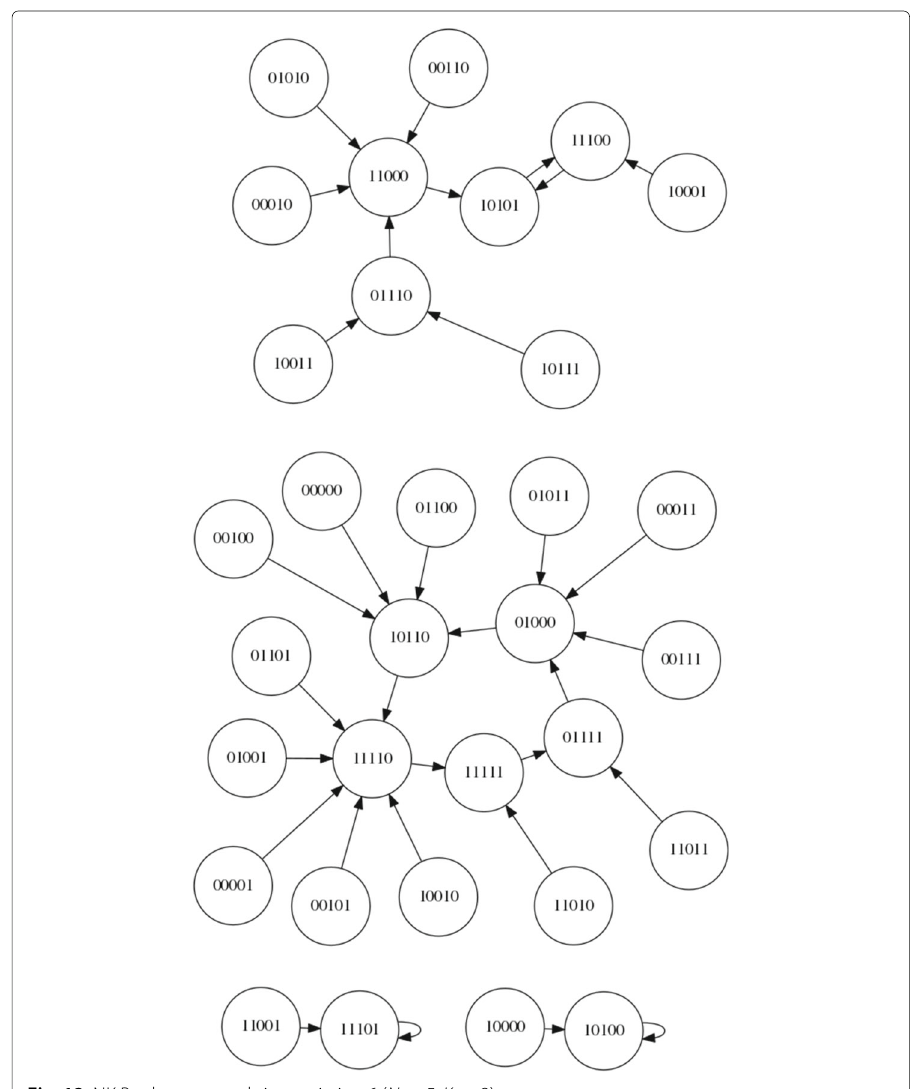
Fig. 12 NK Boolean network, instantiation 6 ( N = 5, K =